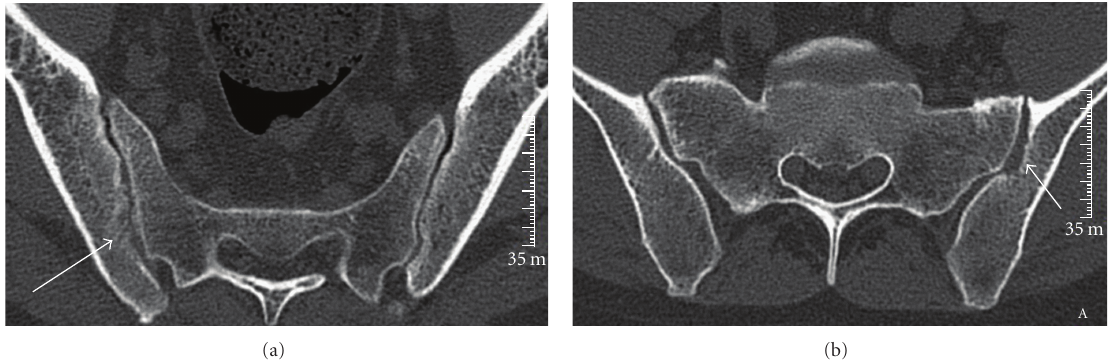
Figure 1: (a) CT scan demonstrates erosions on the right SIJ ( arrow ). (b) CT scan demonstrates erosions on the left SIJ ( arrow ).